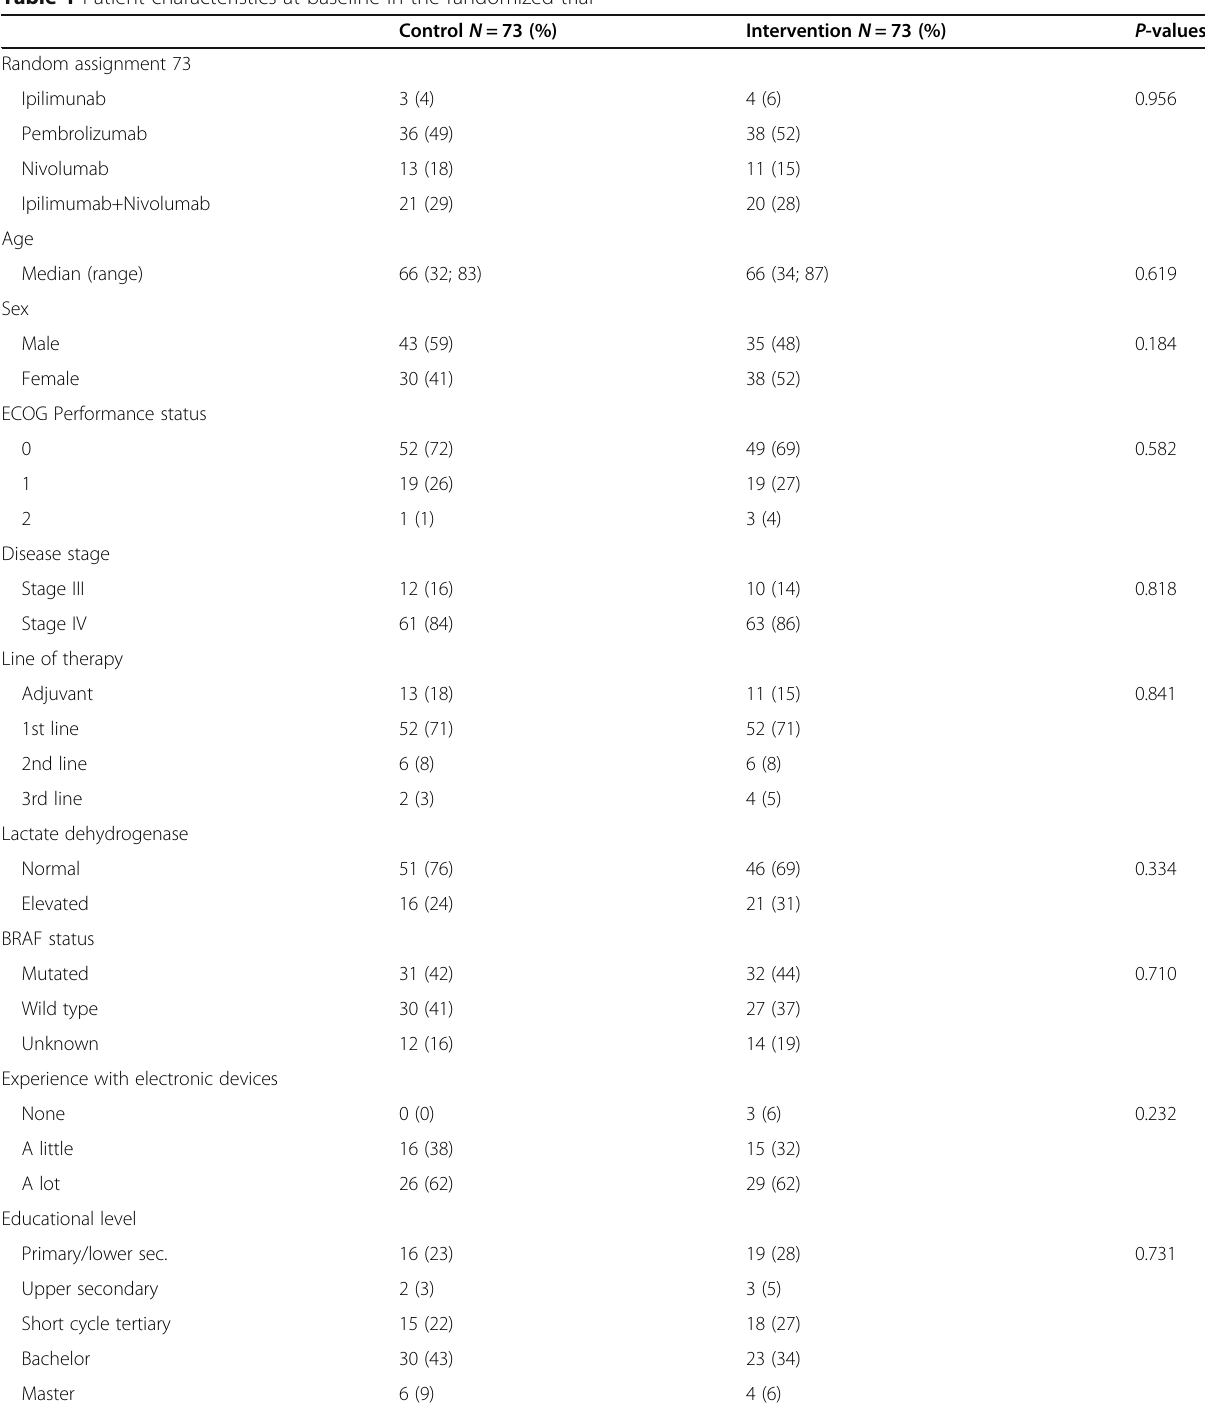
Table 1 Patient characteristics at baseline in the randomized trial